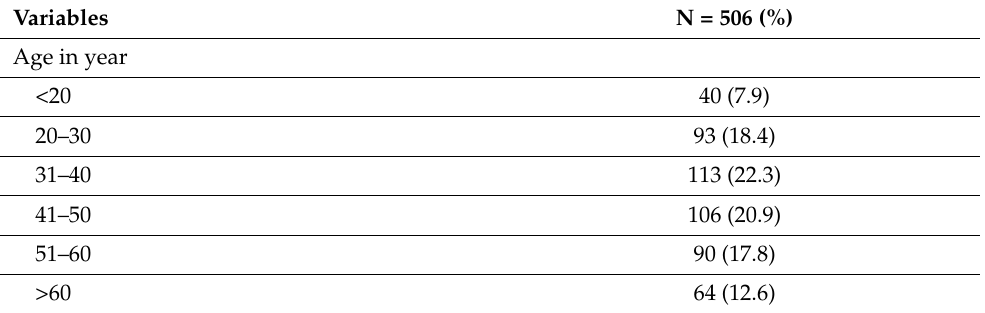
Table 1. Background characteristics of